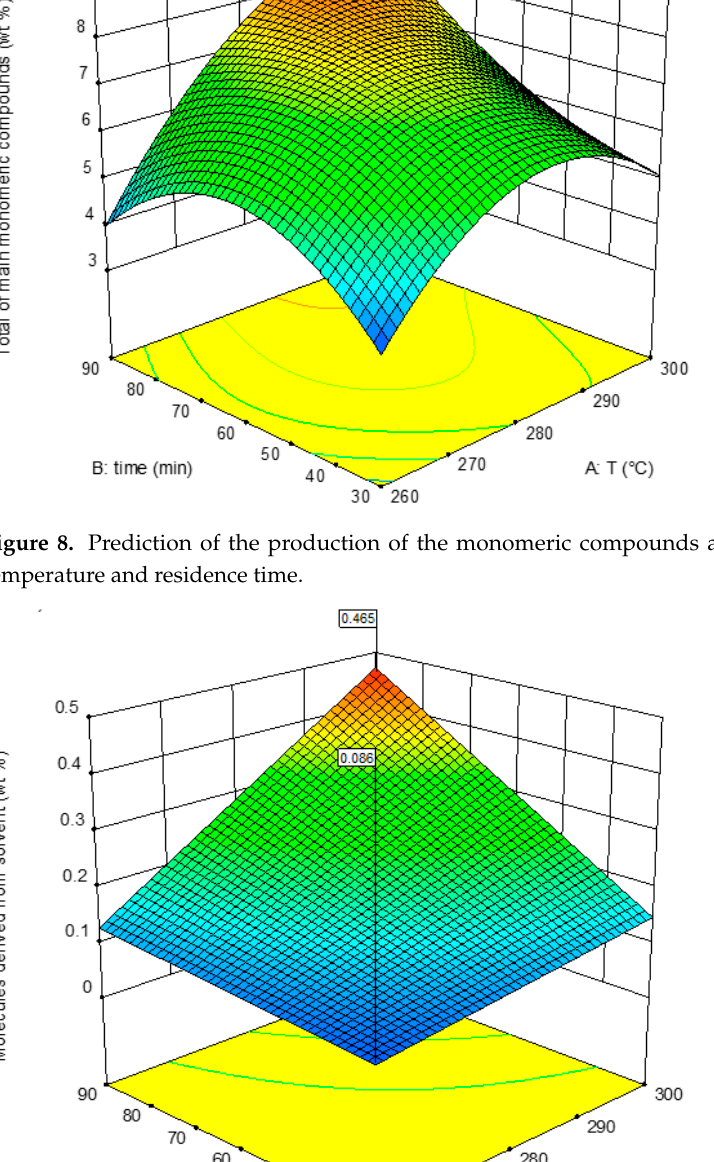
Table 2. Criteria used for reaction parameter optimization.